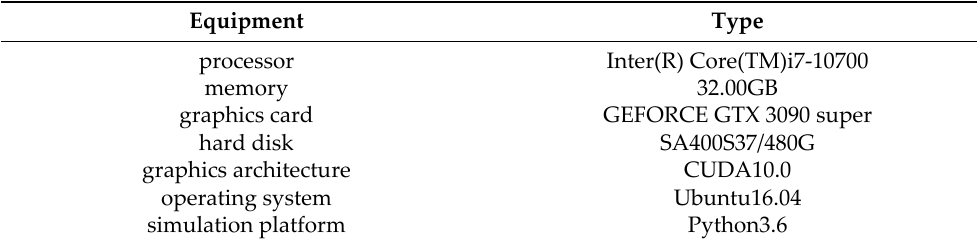
Table 5. Hardware and software used for the experiment.